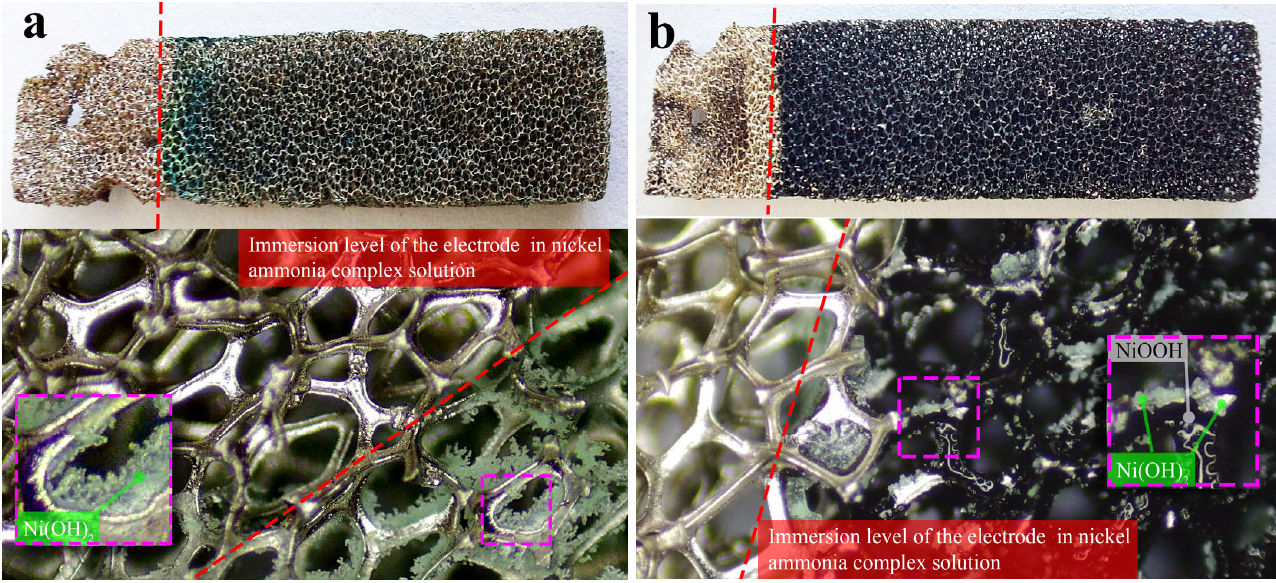
Figure 3. Comparison of the freshly-synthesized and cycled electrodes by means of optical microscopy for the Ni(OH) 2 -pure sample: ( a ) before the charge–discharge experiments; ( b ) after the charge–discharge experiments.